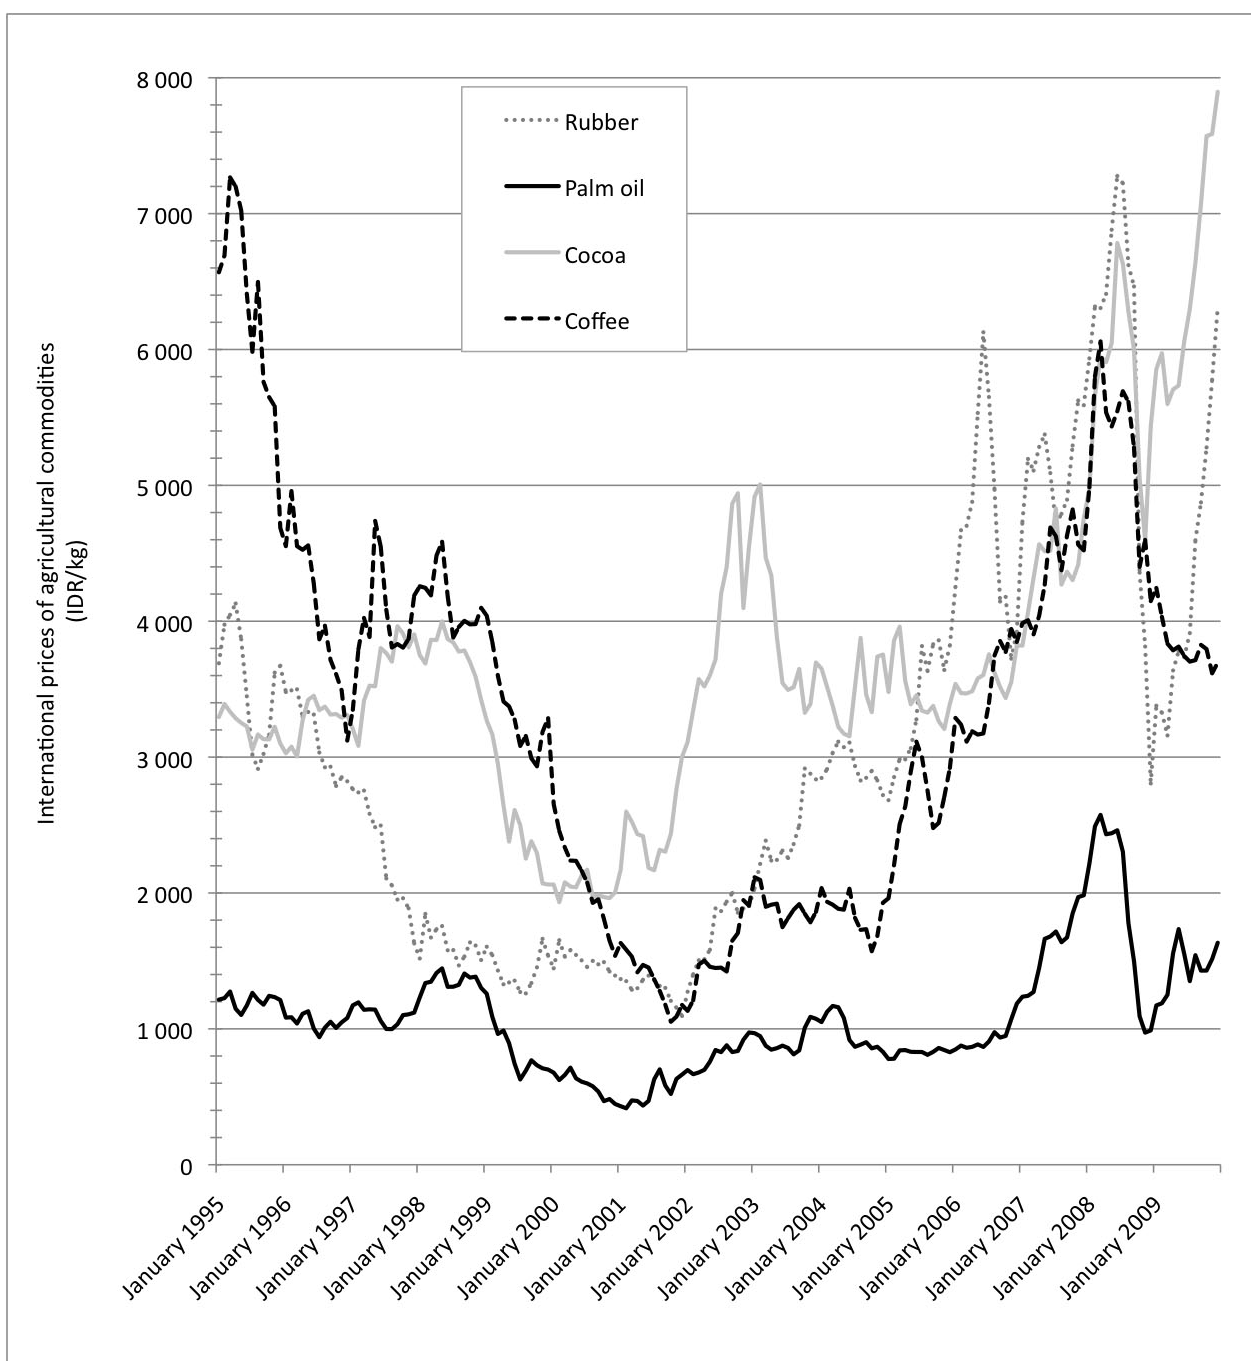
Fig. 6 . Evolution of the prices of the main commodities on the international market. Adapted from Index Mundi (2010), based on data from the International Monetary